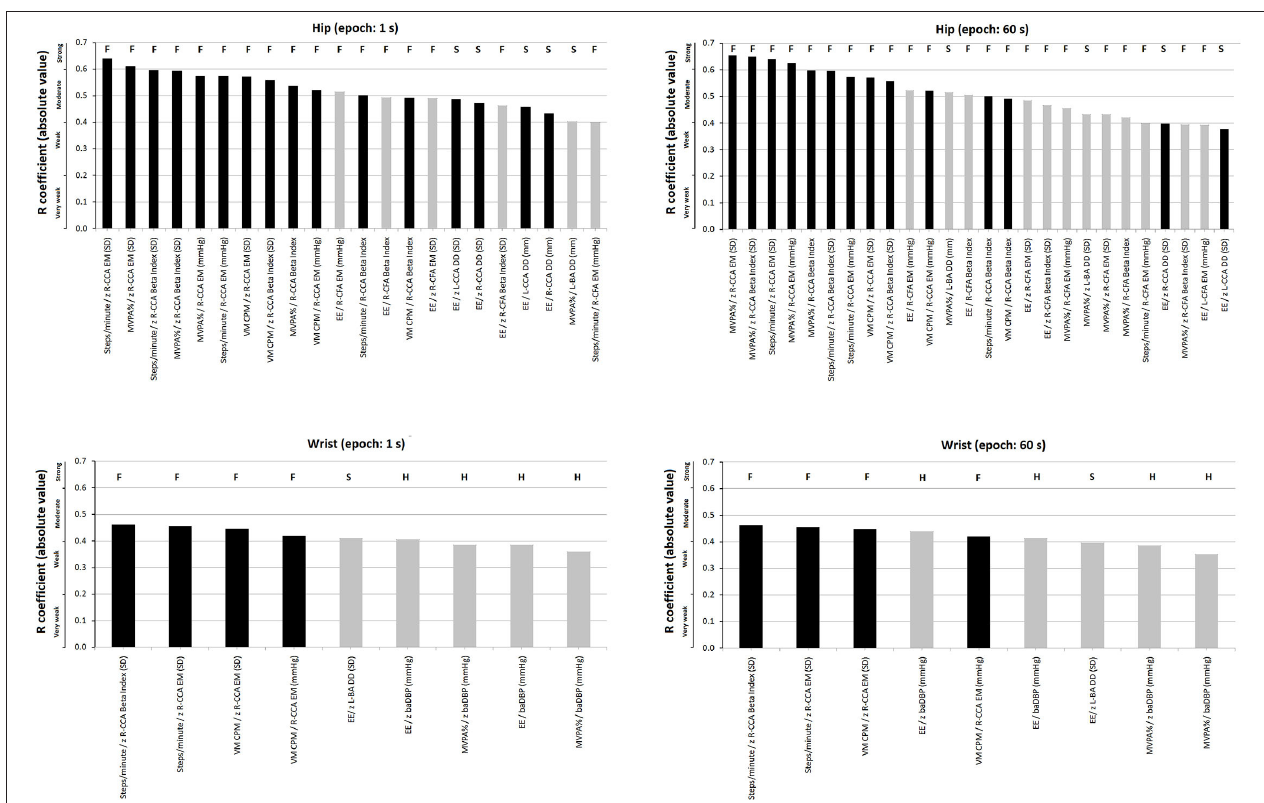
FIGURE 5 | Strength of association ( r coefficients absolute value; partial correlations), ranked from highest to lowest “r,” between accelerometry-derived physical activity indices and cardiovascular properties (measured levels and/or z-scores). Separate charts are presented for wrist and hip, and 1- and 60-s epoch. Only the associations in which statistical significance was reached are plotted. Black and gray bars: central (e.g., common carotid artery, CCA) and peripheral [e.g., common femoral artery (CFA) or brachial artery (BA)] parameters, respectively. The letters above each bar indicate whether it corresponds to a functional (F), structural (S), or hemodynamic (H) parameter. A more extensive description can be found in Supplementary Tables 25 – 28 in Supplementary Material 2 .